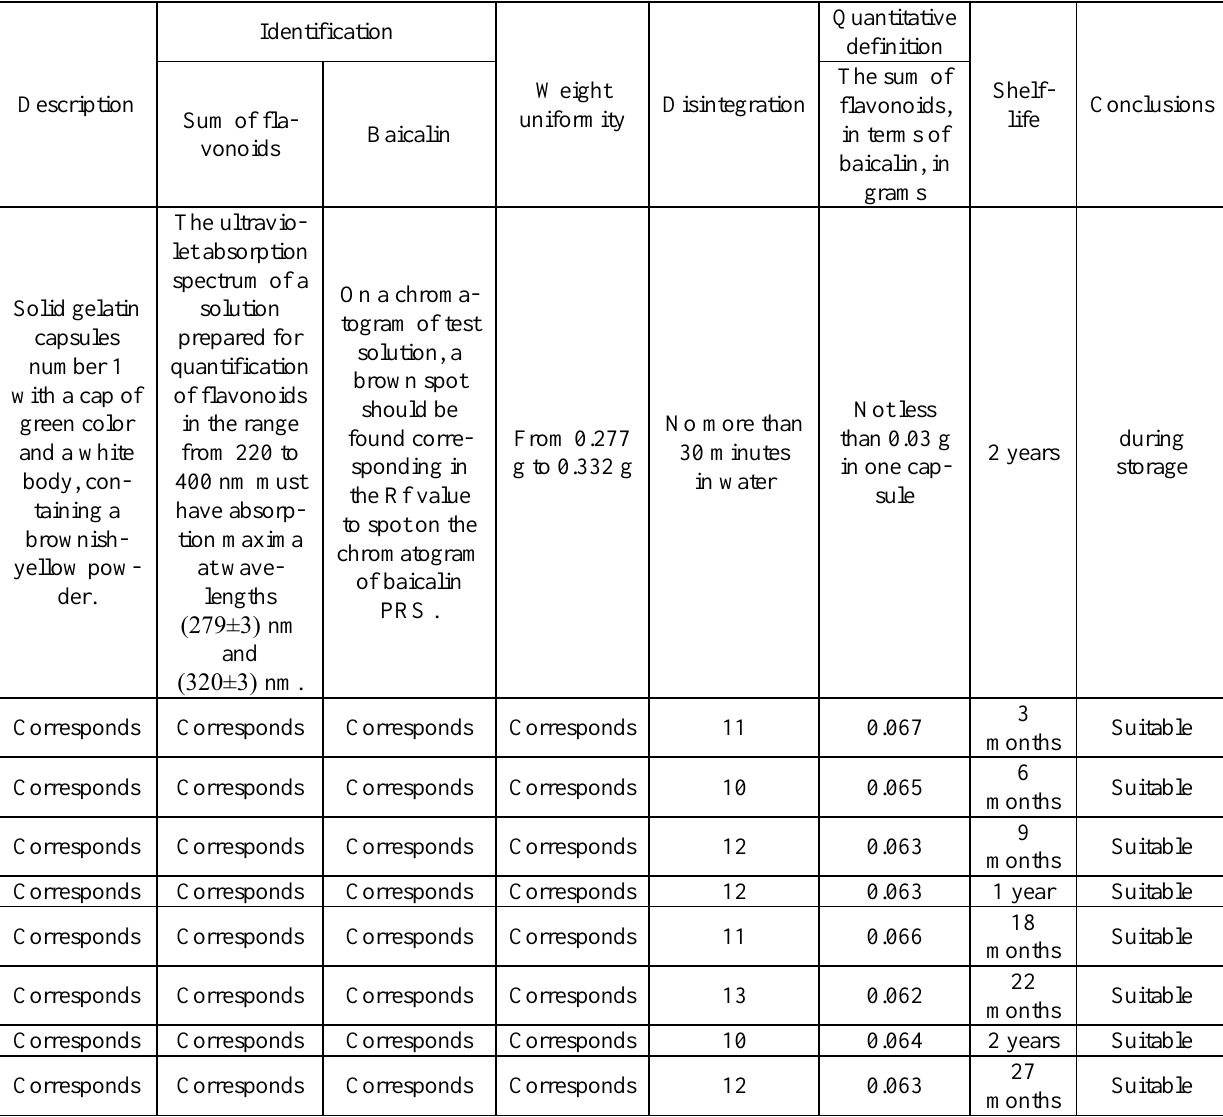
Results of study of stability of capsules under the conditional name "Scutella" during